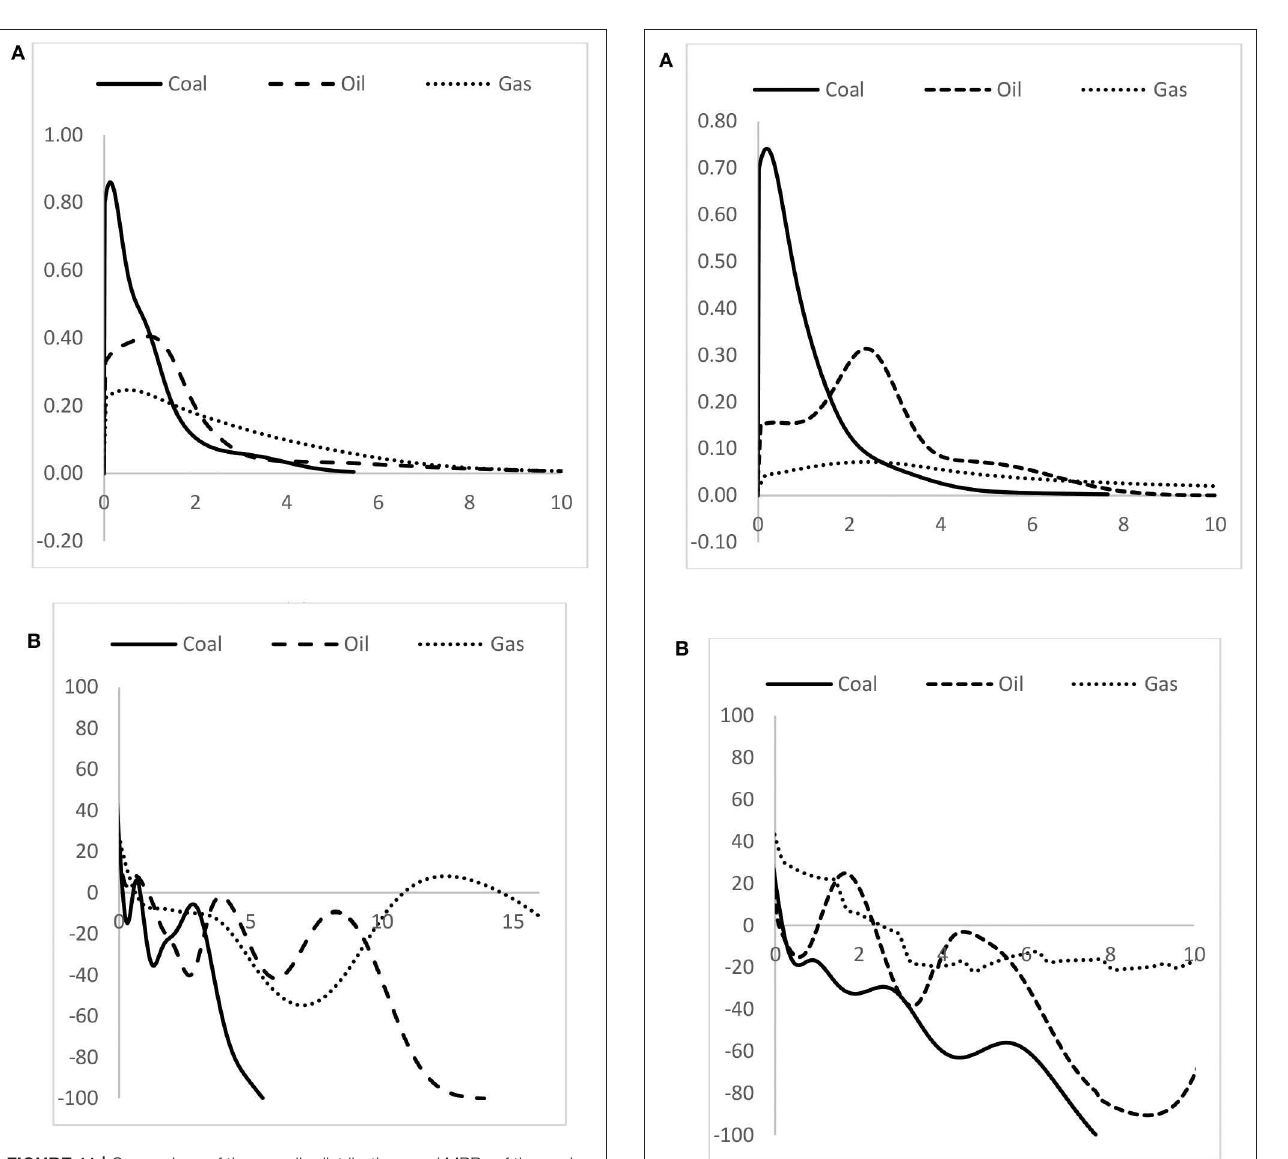
FIGURE 11 | Comparison of the ergodic distributions and MPPs of the coal, oil, and gas markets for the upper-middle-income countries. Note: For (A) , horizontal axis represents relative per capita consumption, vertical axis represents proportion. For (B) , horizontal axis represents relative per capita consumption, vertical axis represents MPP. Source: Authors’ calculation.